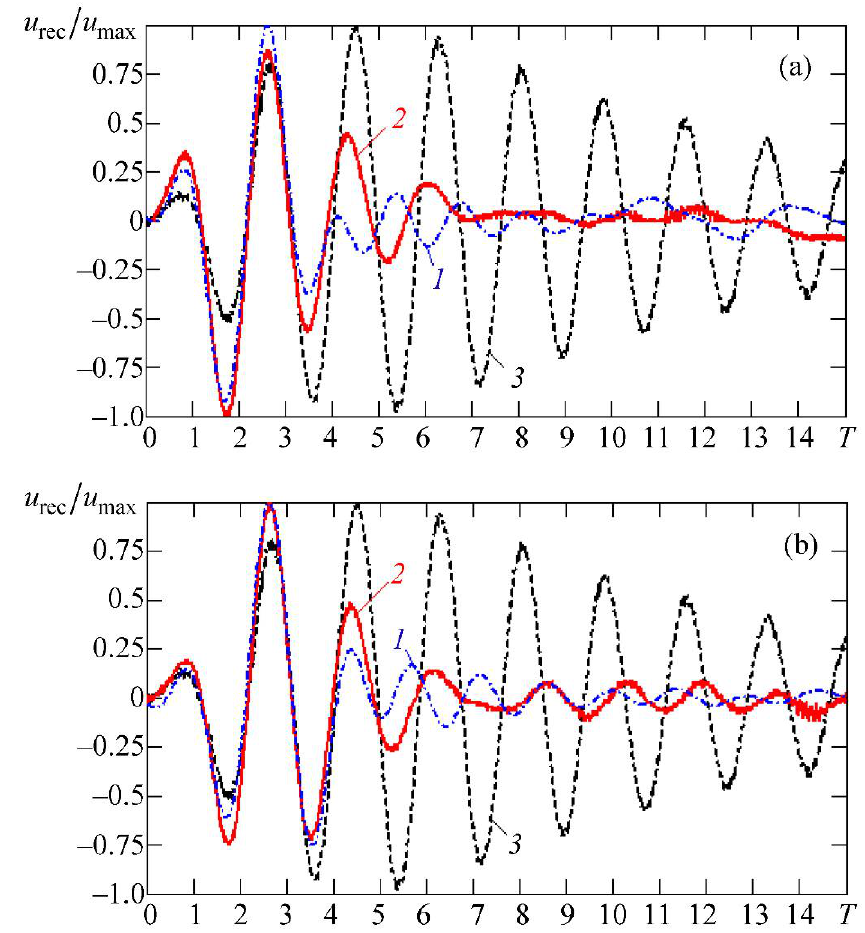
Figure 4. Shapes of electrical signals at the output of the: ( a ) shows the results when the emitter receives the signal shown in Figure 2b; ( b ) shows the results when the radiating plate is excited by the electrical pulse that is shown in Figure 2c.